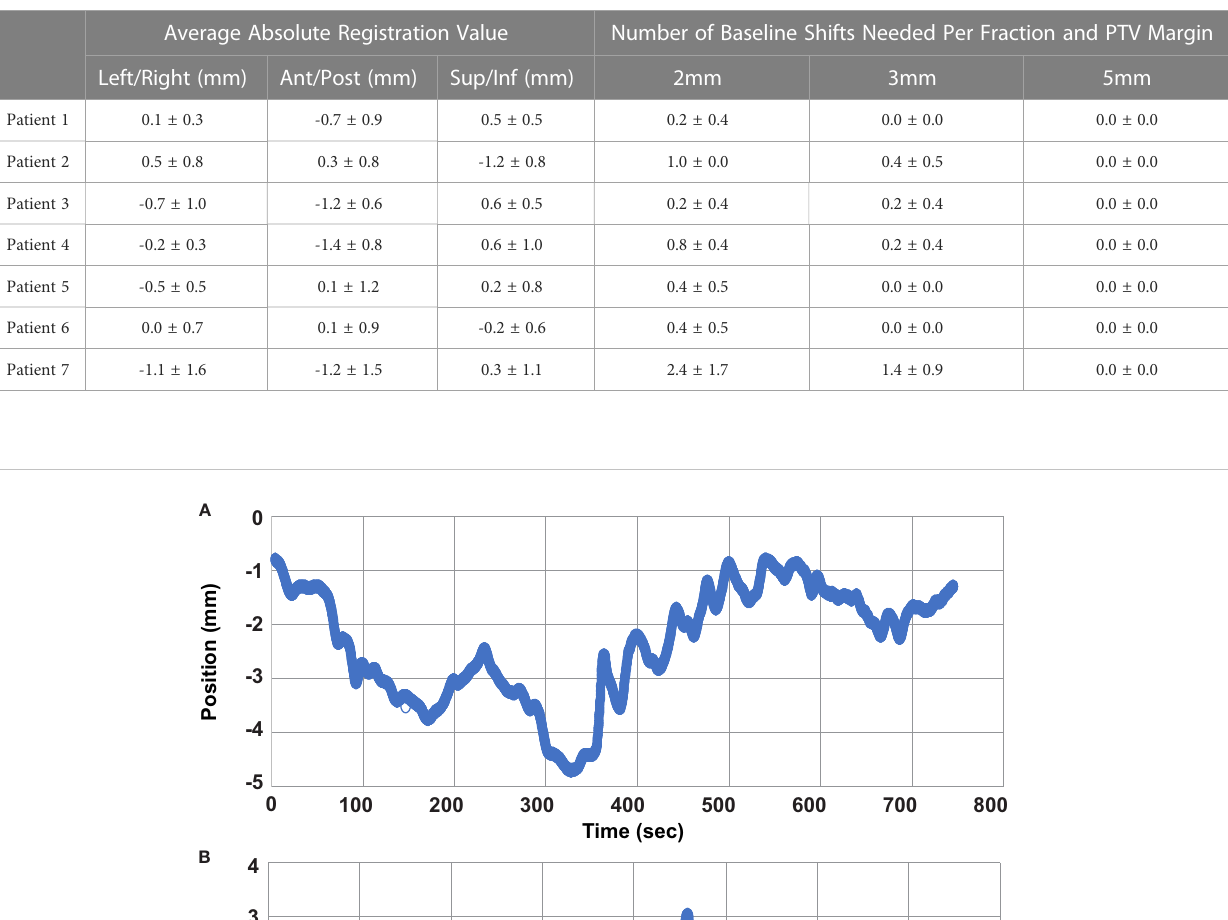
TABLE 1 Patient Intra-Fraction Motion Metrics.